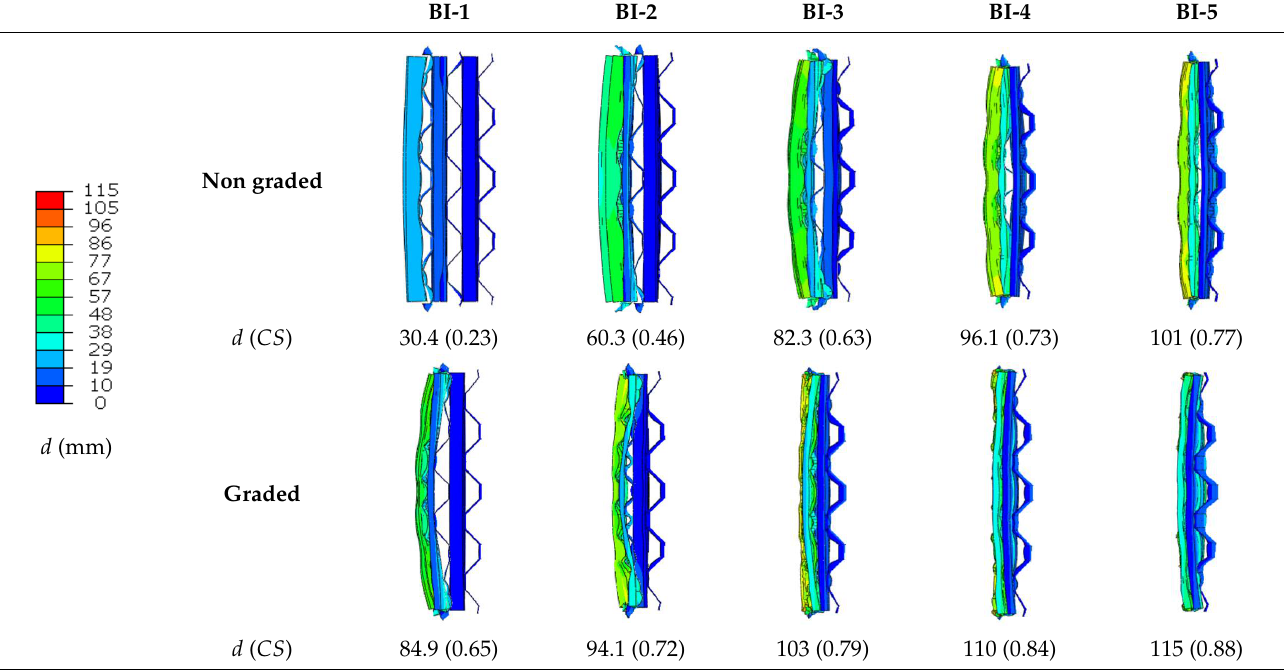
Figure 14. Peak deformations (mm) of the graded sandwich panel showing frontal layer damage and last layer minor deformations, when subjected to 0.5 kg of TNT at R = 0.5 m (BI-5). ( a ) graded core and frame; ( b ) graded core; ( c ) front layer; ( d ) last layer.